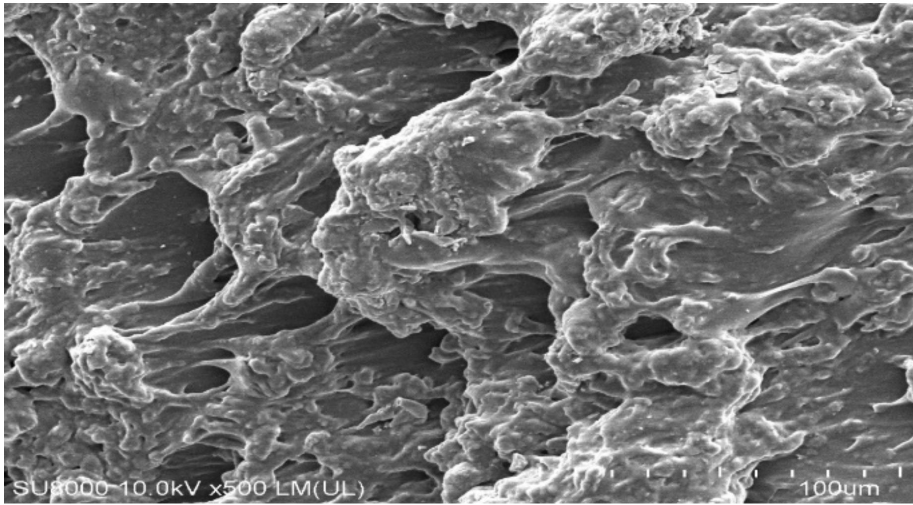
Figure 1. Morphological analysis of CS/CBP-co-PAA